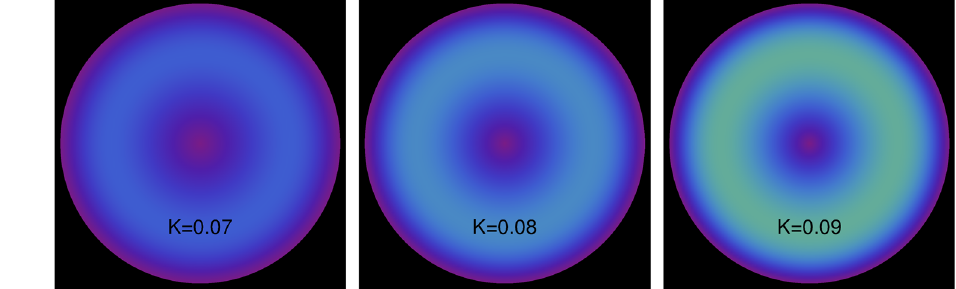
Fig. 9 Radial pressure [ 6 ˜ p r ( r , K ) × 10 3 ] as a function of ( r , K ) for n = 0 . 05 (left panel) and [ 6 ˜ p r ( r , n ) × 10 3 ] as a function of ( r , n ) for K = 0 . 01(right panel) Fig. 10 Exchange of energy [ 2 Δ E × 10 4 ] for n = 0 . 5 and three different values of K . The exchange grows as K